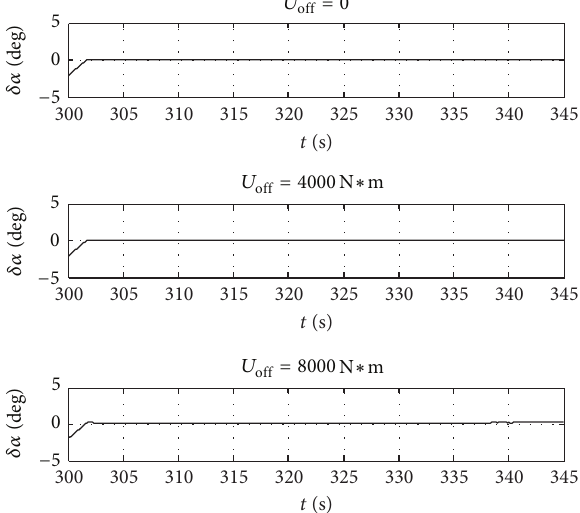
Figure 25: Simulation result of attack angle deviation.